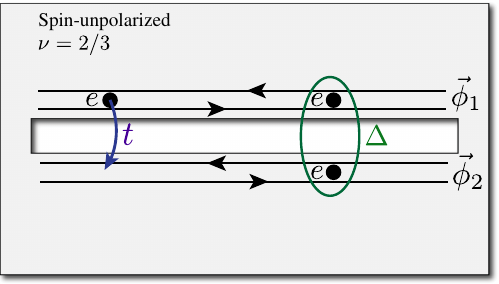
FIG. 4. Spin-unpolarized ν ¼ 2 = 3 setup with a long, narrow trench producing counterpropagating sets of edge states de- ⃗ ϕ ⃗ ϕ scribed by fields 1 on the top and 2 on the bottom. One way of gapping these modes is through electron backscattering across the interface — which essentially “ sews up ” the trench. A second gapping mechanism can arise if an s -wave superconduc- tor mediates spin-singlet Cooper pairing of electrons from the top and bottom sides of the trench, as illustrated above. These processes lead to physically distinct gapped states that cannot be smoothly connected, resulting in the formation of Z 3 gener- alized Majorana zero modes at domain walls separating the